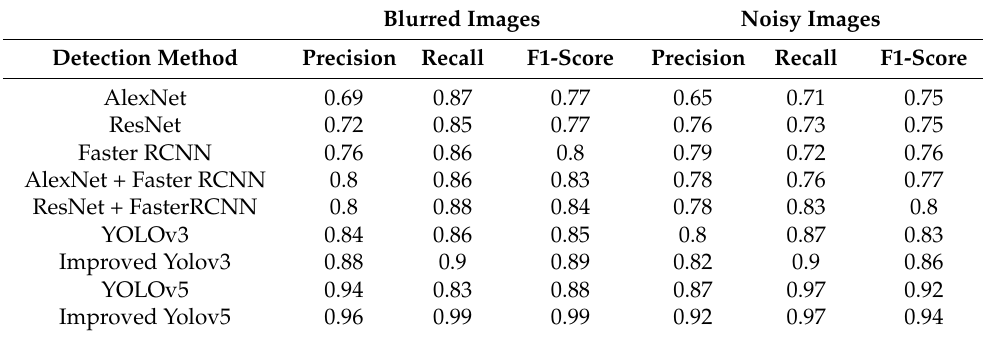
Table 2. Comparative performance for Blurred Images and Noisy Images. Blurred Images Noisy Images Detection Method